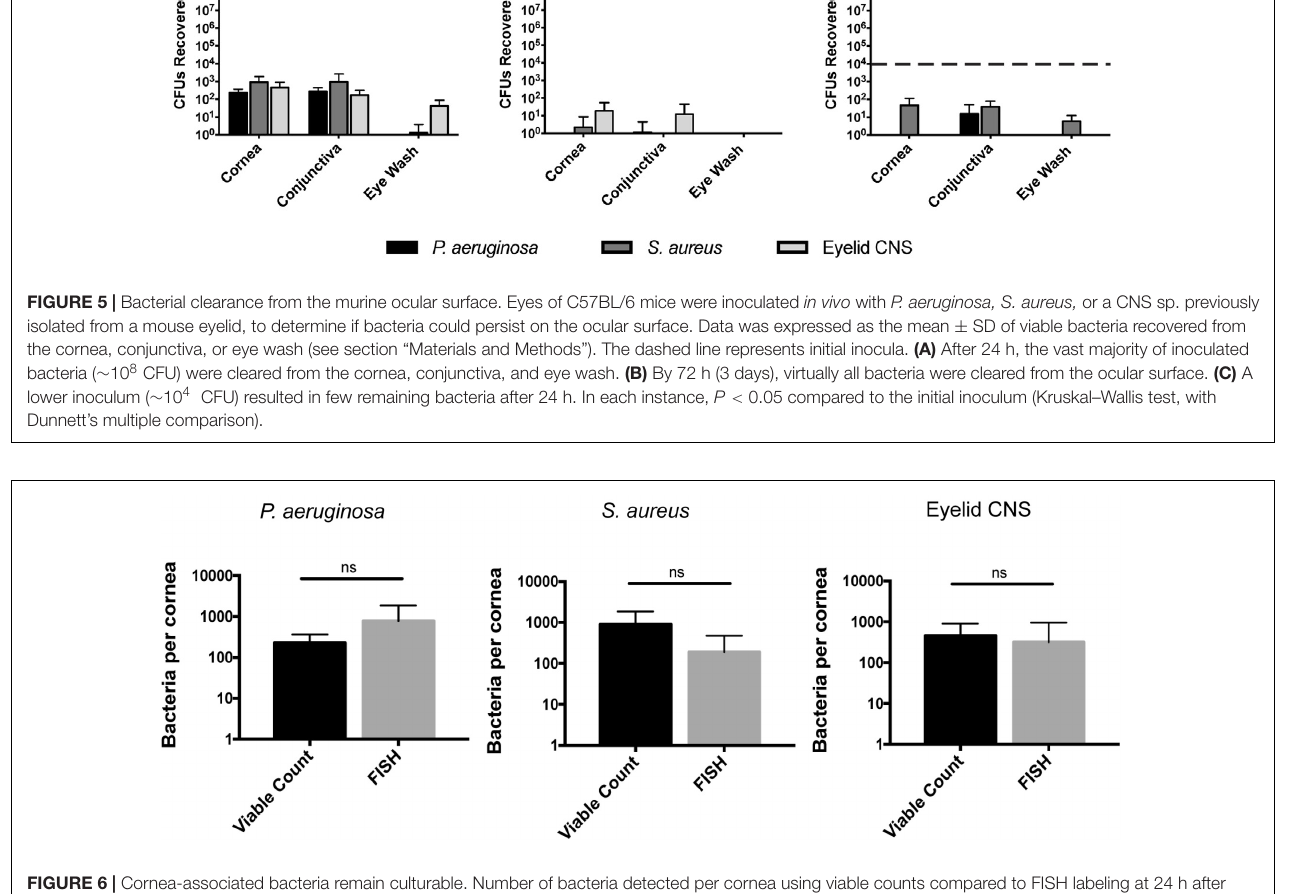
Frontiers in Microbiology |